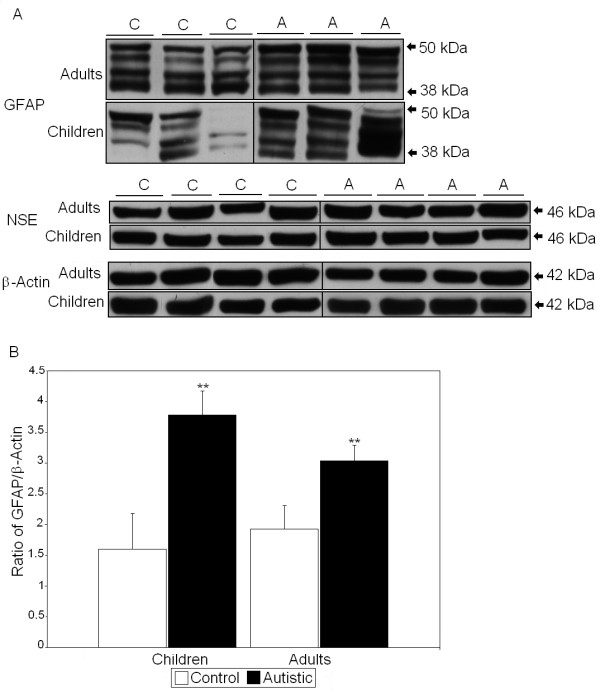
(A) Representative samples of glial fibrillary acidic protein (GFAP), neuron-specific enolase (NSE) and β-actin from controls (C) and people with autism (A). (B) Mean GFAP/β-actin ratios for people with autism (filled histogram bars) and controls are shown for Brodmann's area 9 (BA9). Error bars express standard error of the mean. **P < 0.05.